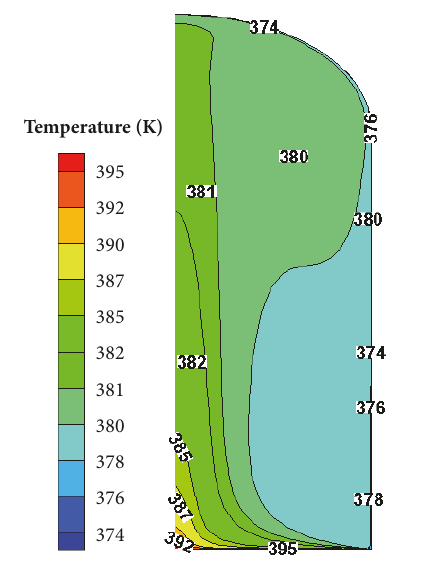
Figure 13: Temperature contour in the AP1000